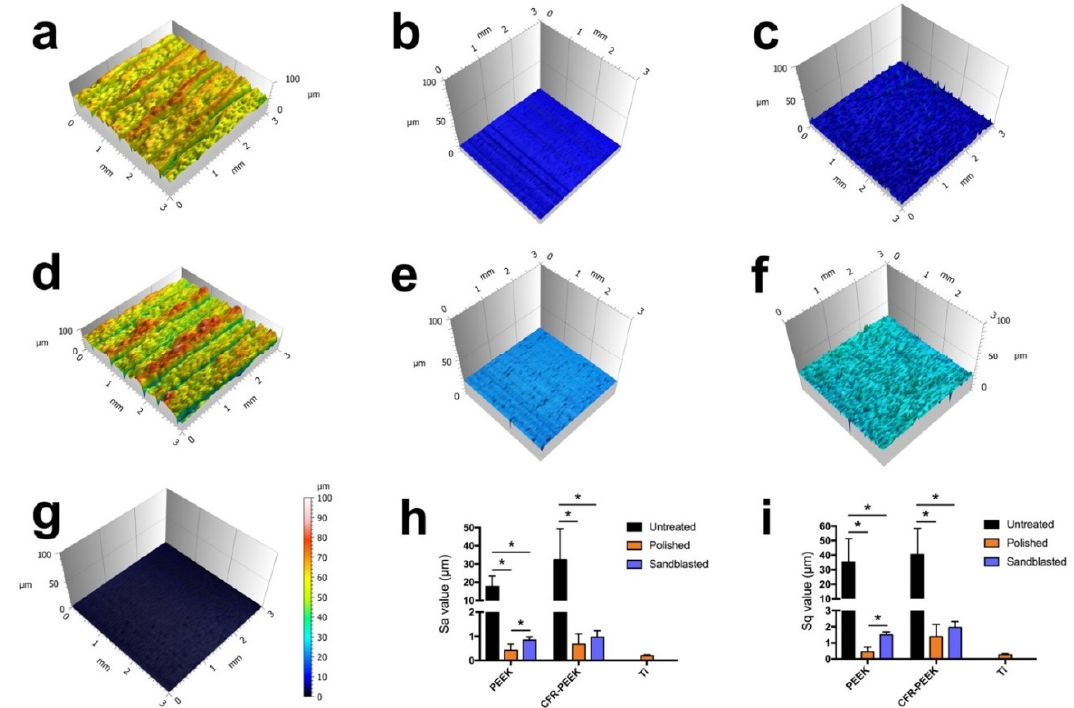
Figure 4. Reconstructed three‐dimensional (3D) surface topographies of analyzed samples, and Sa and Sq values: ( a ) untreated PEEK; ( b ) polished PEEK; ( c ) sandblasted PEEK; ( d ) untreated CFR‐PEEK; ( e ) polished CFR‐PEEK; ( f ) sandblasted CFR‐PEEK; ( g ) polished Ti; ( h ) and ( i ) Sa and Sq values of as‐printed, polished, and sandblasted PEEK and CFR‐PEEK samples, the polished Ti was used as an additional reference. The data are presented as means ± standard deviation, * p < 0.05.